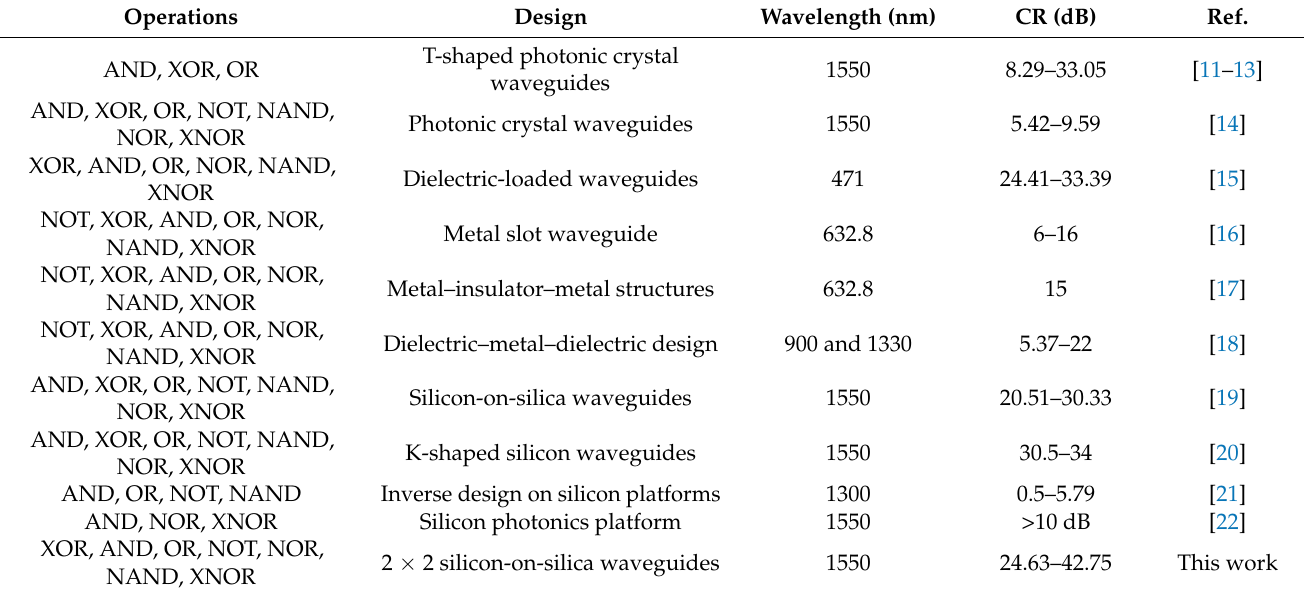
Table 9. Evaluation of the proposed design in comparison to other published waveguide-based logic